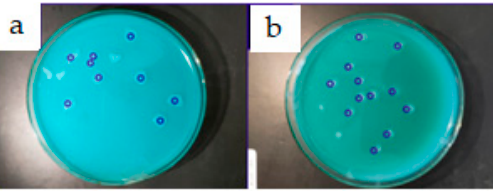
Figure 6. Blue agar plate method. BS positive (dark blue halo). ( a , b ). Source: [83].